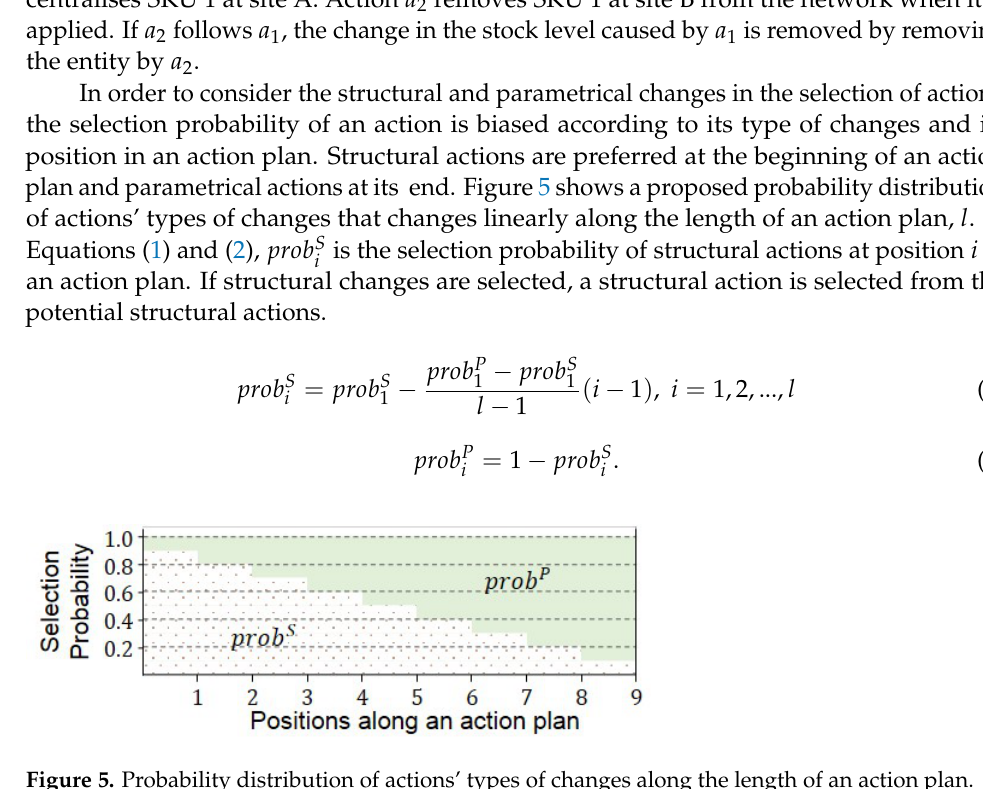
Figure 5. Probability distribution of actions’ types of changes along the length of an action